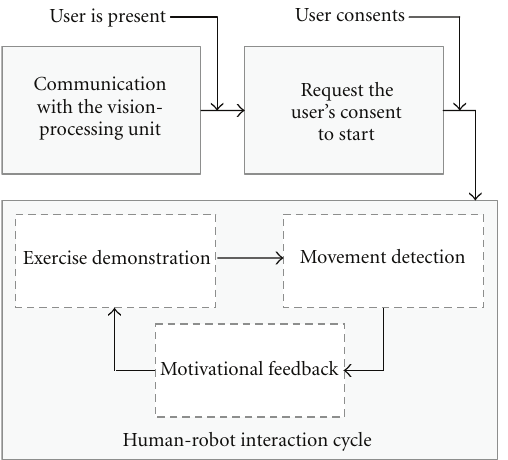
Figure 4: In the exercise adherence interaction framework, the interaction is controlled mainly by the user’s consent to participate. Consent is requested both before the first exercise and after each completed exercise.